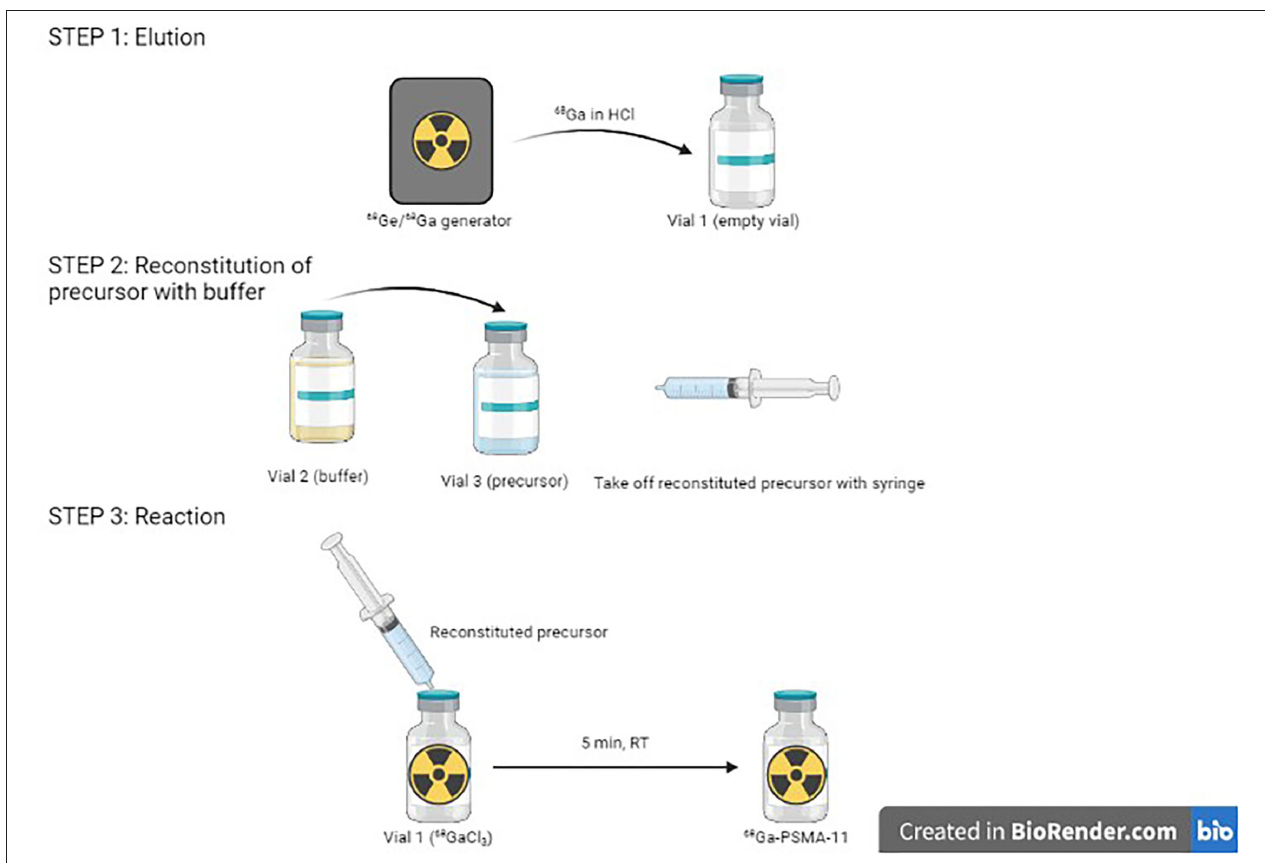
FIGURE 4 | Procedure for the preparation of 68 Ga-HBED-CC-PSMA-11 (Telix